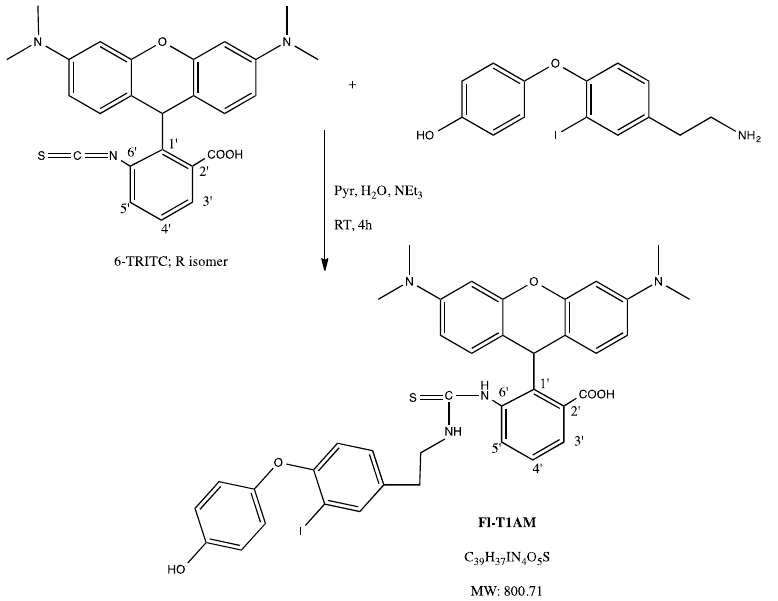
Figure 1. Synthesis of fluorescently labeled T1AM (FL-T1AM). One-step conjugation of Tetramethylrhodamine- 6-isothiocyanate (6-TRITC) with T1AM e ffi ciently produces fluorescently- labeled T1AM (FL-T1AM).